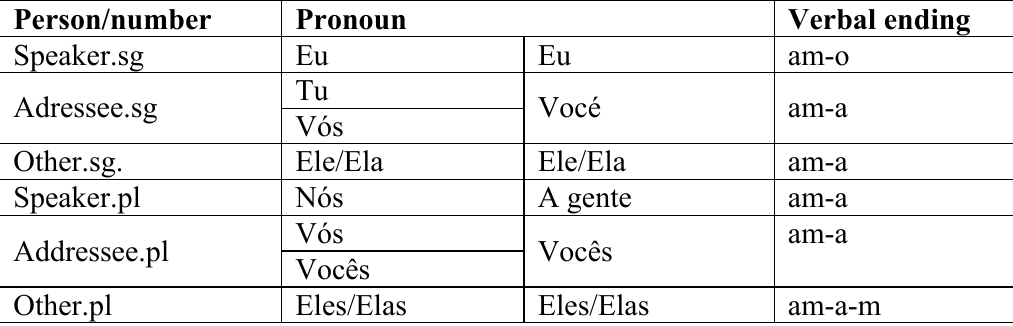
Table 2. Evolution of the pronominal paradigm in BP